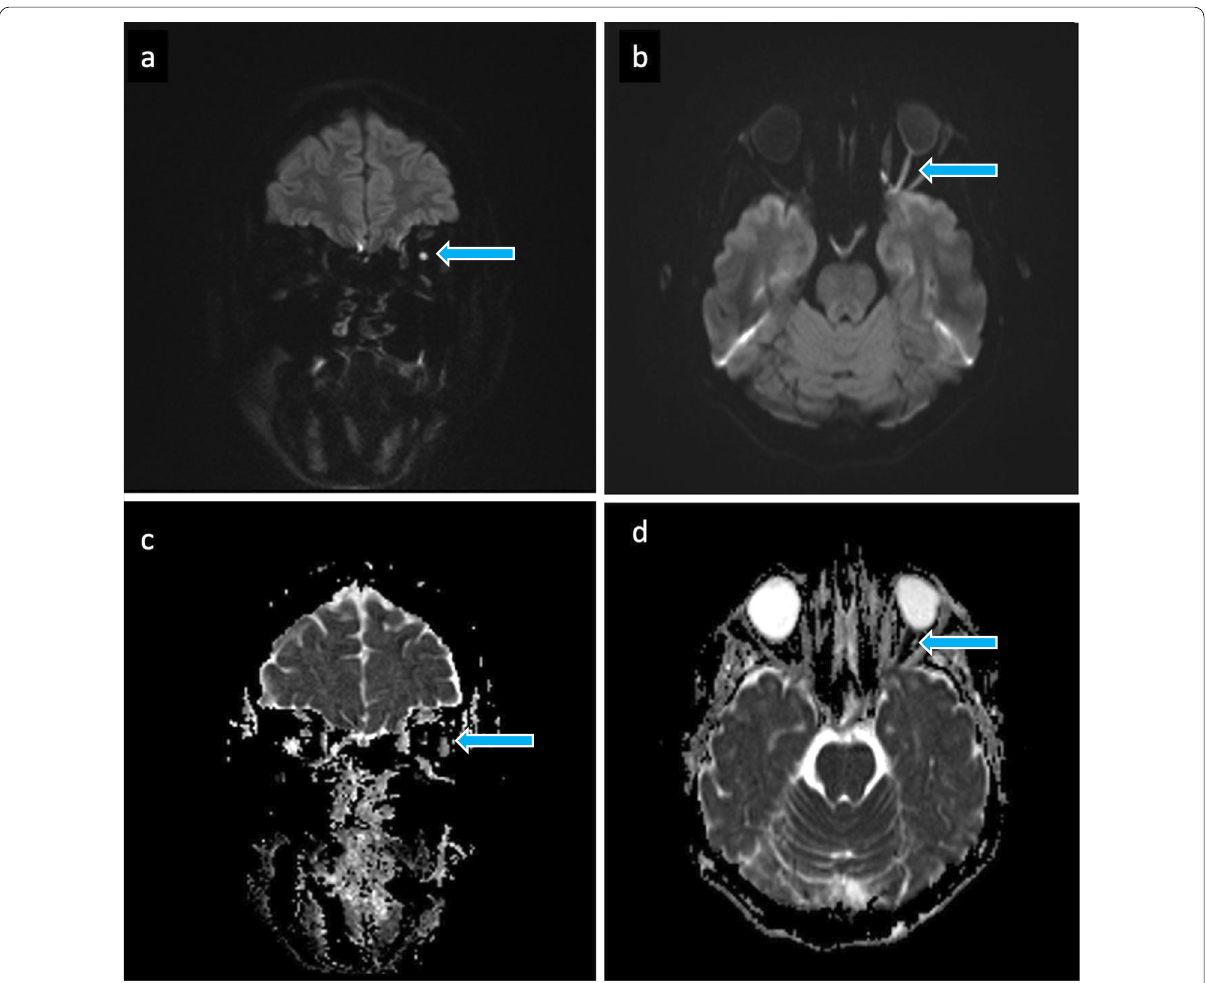
Fig. 3 MRI of the brain 1.5 weeks after the HA filler injection. Coronal ( a ) and axial ( b ) diffusion weighted imaging (DWI) b corresponding apparent diffusion coefficient (ADC) maps ( c , d ) highlighting more pronounced signal changes in the left optic